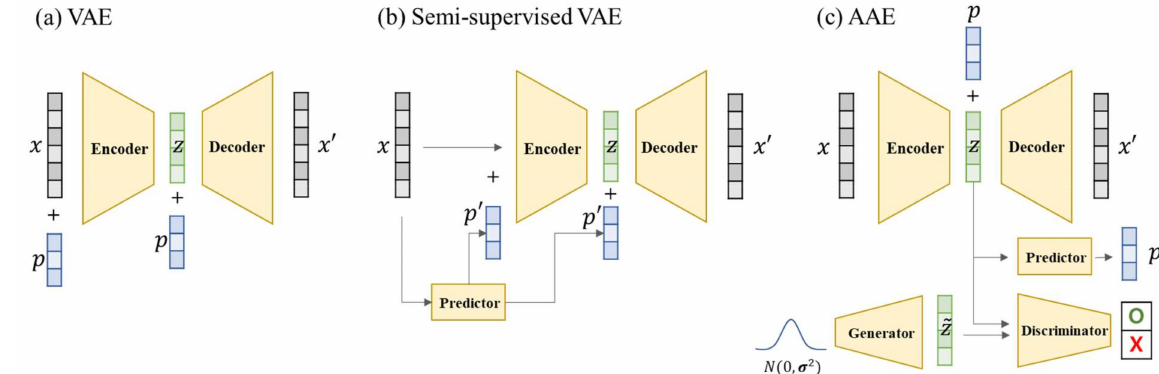
Figure 4. Three types of conditional de novo model using VAE. z is a latent vector and p is a molecular property. ( a ) Basic model for property control [45]. Concatenate the molecular property with the input value to the encoder and decoder. ( b ) Model with the property predictor [155] added to ( a ). It is possible to train even for molecules without the property data. ( c ) Model with condition control applied to the AAE [156]. Modify the latent space by predicting properties from the latent vector. This model does not add any properties to the encoder.